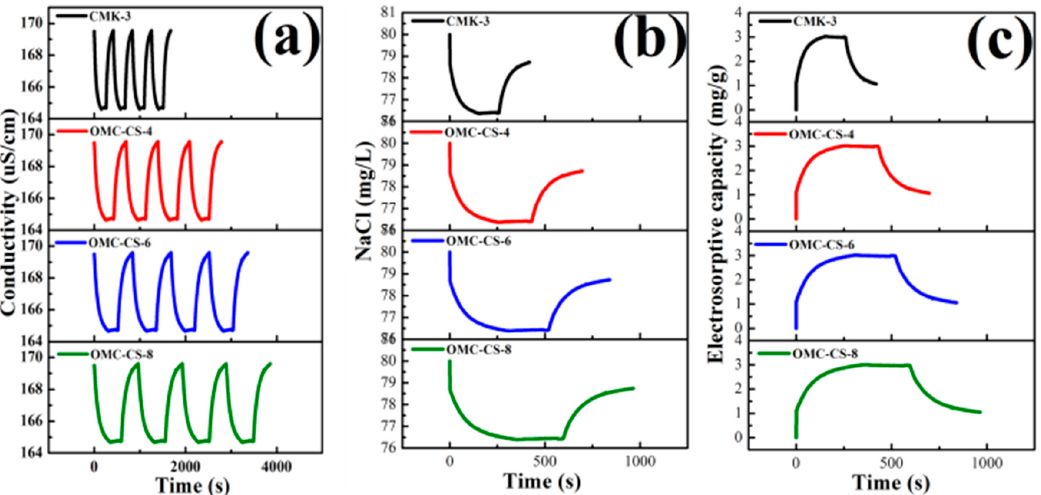
Figure 6. ( a ) Conductivity/time profiles of CMK-3 and OMC-CS-4,6,8 at NaCl 80 mg ∙ L − 1 ; ( b ) Effluent NaCl concentration/time profiles of CMK-3 and OMC-CS-4,6,8 at 1.2 V; ( c ) Electrosorptive capacity/time profiles of CMK-3 and OMC-CS-4,6,8 at 1.2 V.